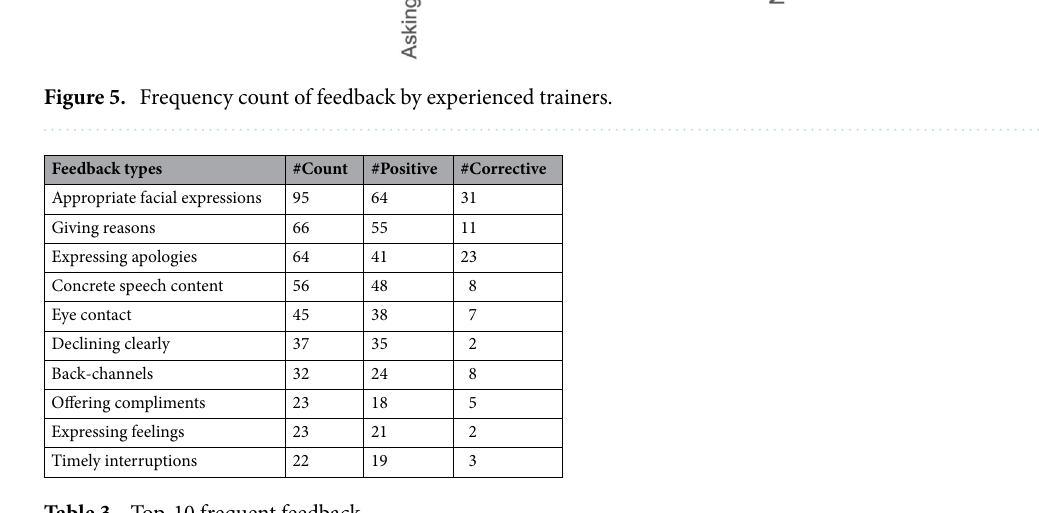
Table 3. Top-10 frequent